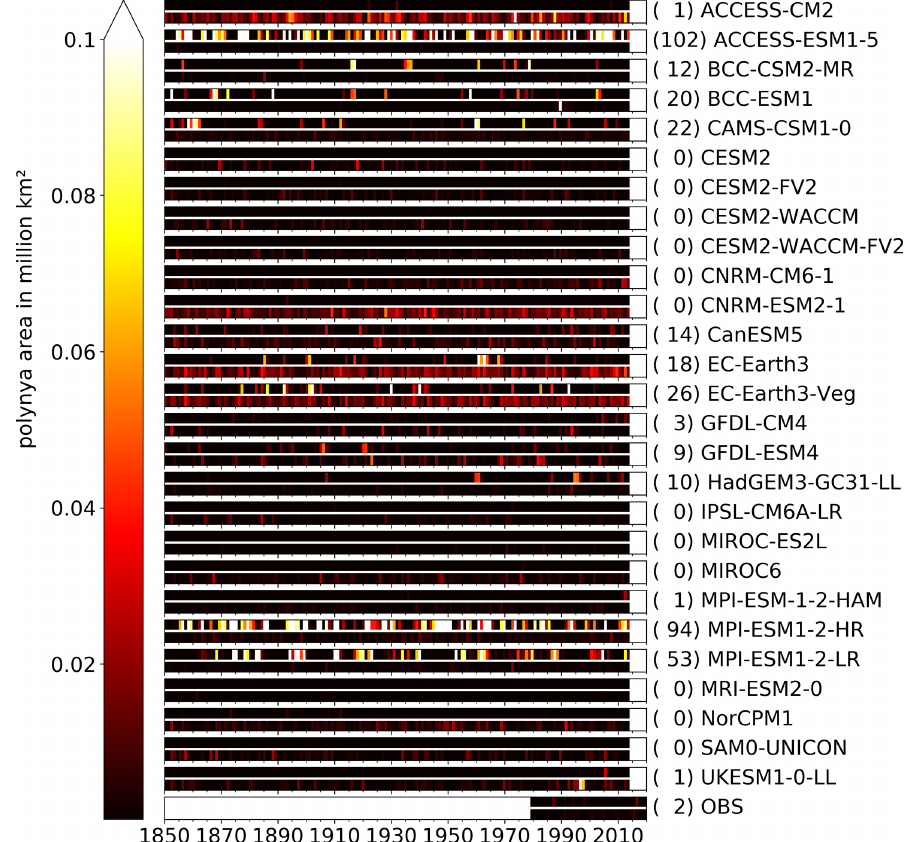
Figure A6. Yearly mean polynya area between May and November in the historical CMIP6 model run for the Weddell Sea region, computed from monthly sea ice concentrations. Each bar represents one CMIP6 model and is divided horizontally into coastal polynya area (upper bar) and OWP area (lower bar). The values next to the model name represent the number of years an open-water polynya with an area of more than 10 . 0 × 10 3 km 2 was